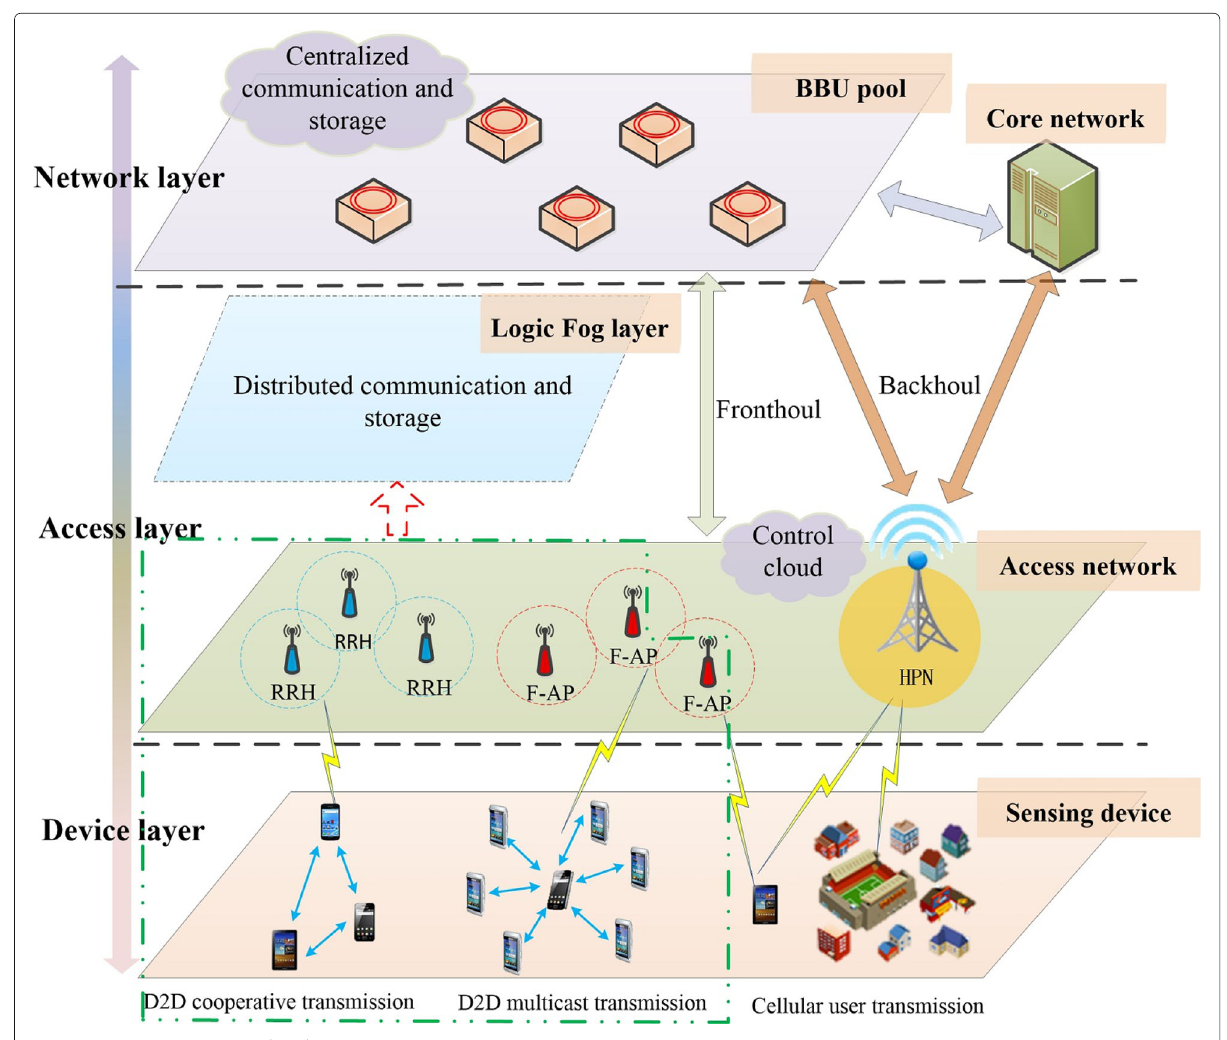
Fig. 1 Fog computing network